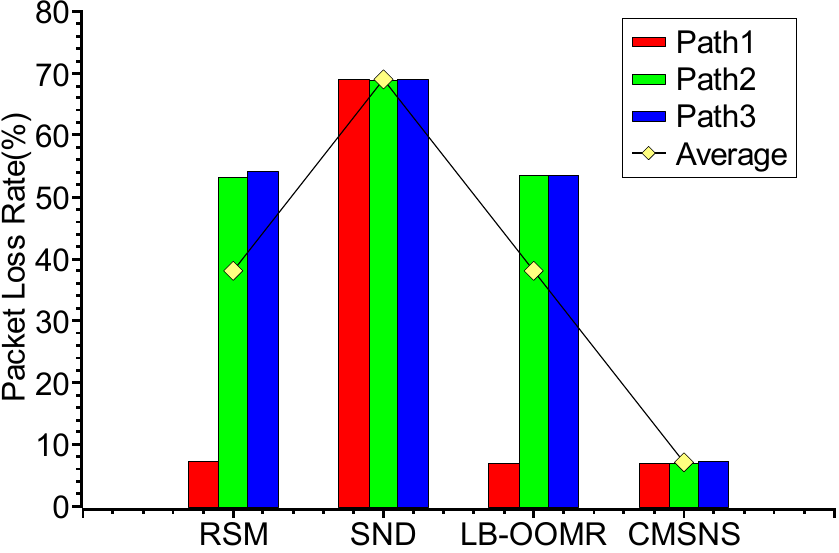
Figure 11. Packet Loss Rate under Different Node Selection